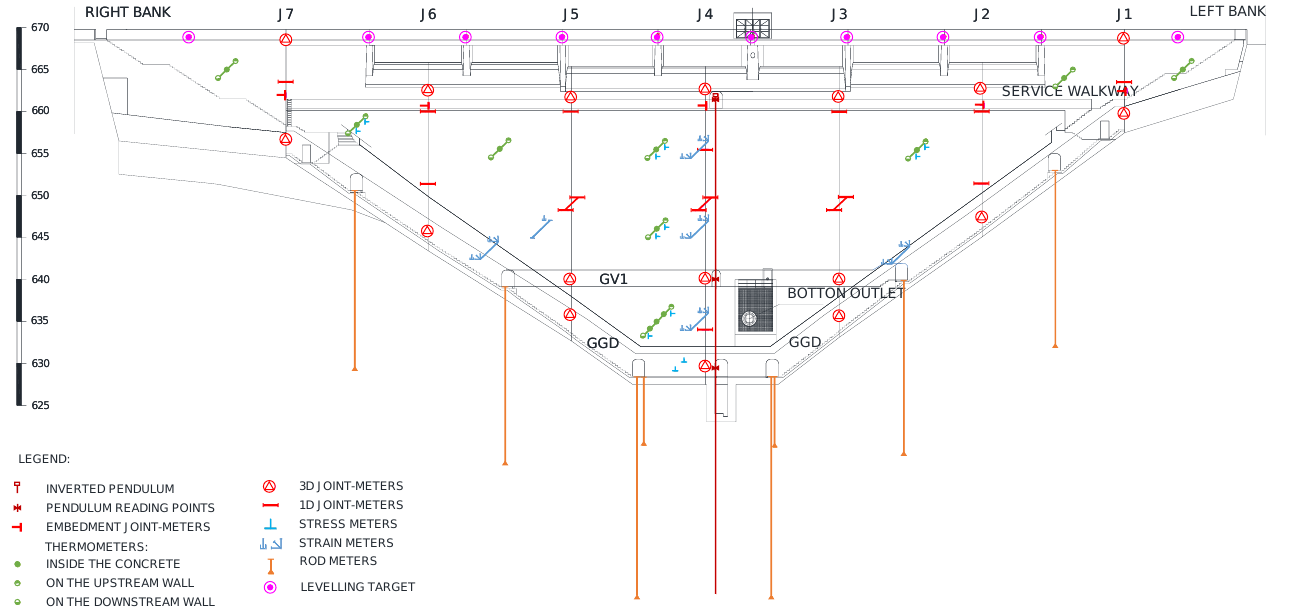
Figure 5. Structural response monitoring system.